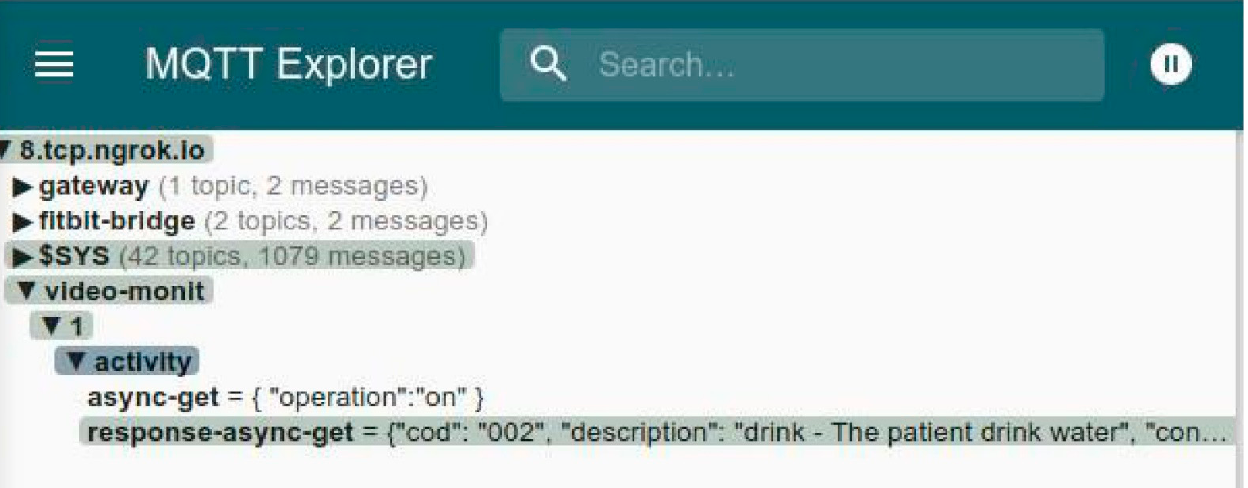
Figure 20. MQTT message sent to the SmartCare Gateway.